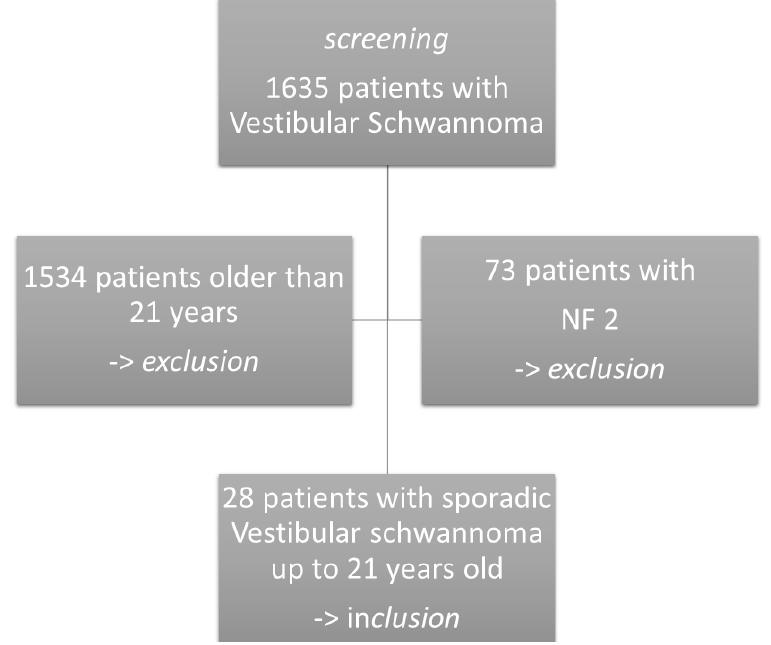
Figure 1. Flow chart of patient inclusion. NF2: Neurofibromatosis Type 2